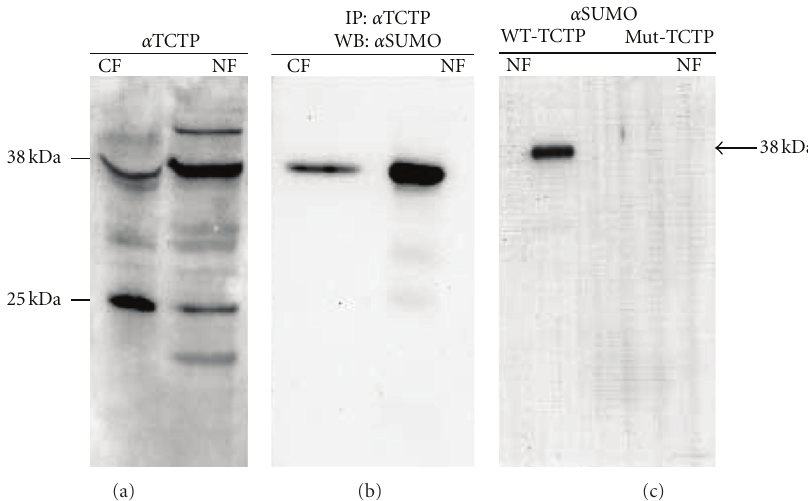
Figure 2: TCTP present in the nucleus is sumoylated. Lanes 1 and 2 show the proteins in the cytoplasm (CF) and nuclear (NF) fractions probed with an anti-TCTP antibody (a). The TCTP was then immunoprecipitated from these fractions using the anti-TCTP antibodies and the precipitate was subsequently probed with an anti-SUMO antibody (b). Lanes 3 and 4 show that sumoylated TCTP is present in both cytoplasm and nucleus. In order to determine if sumoylation is critical for the transport of TCTP into the nucleus, we used a FLAG-tagged TCTP to monitor the movement of TCTP inside the cell. Cos1 cells were transfected with either FLAG-tagged wild-type TCTP (W) or FLAG-tagged mutated TCTP (M). To determine whether the FLAG-tagged TCTPs were sumoylated, an anti-FLAG monoclonal antibody was used to immunoprecipitate the FLAG-tagged TCTP from the cytoplasm and nuclear fractions of the Cos1 cells. The bound TCTPs were then eluted, separated on a 12% gel, transferred to a nitrocellulose sheet, and probed with polyclonal anti-SUMO antibodies (c). These studies confirm that the high molecular weight form of wild-type TCTP present in the nuclear fraction is sumoylated. Results presented are representative of three similar experiments.